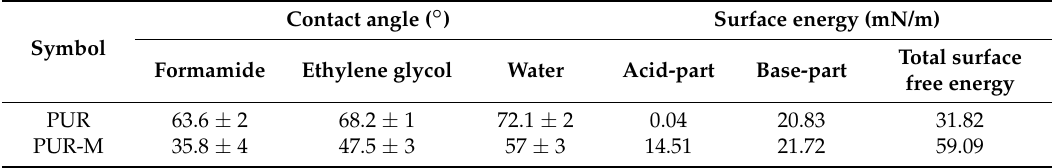
Table 5. Contact angle and total surface free energy of obtained PURs and PURs-M.